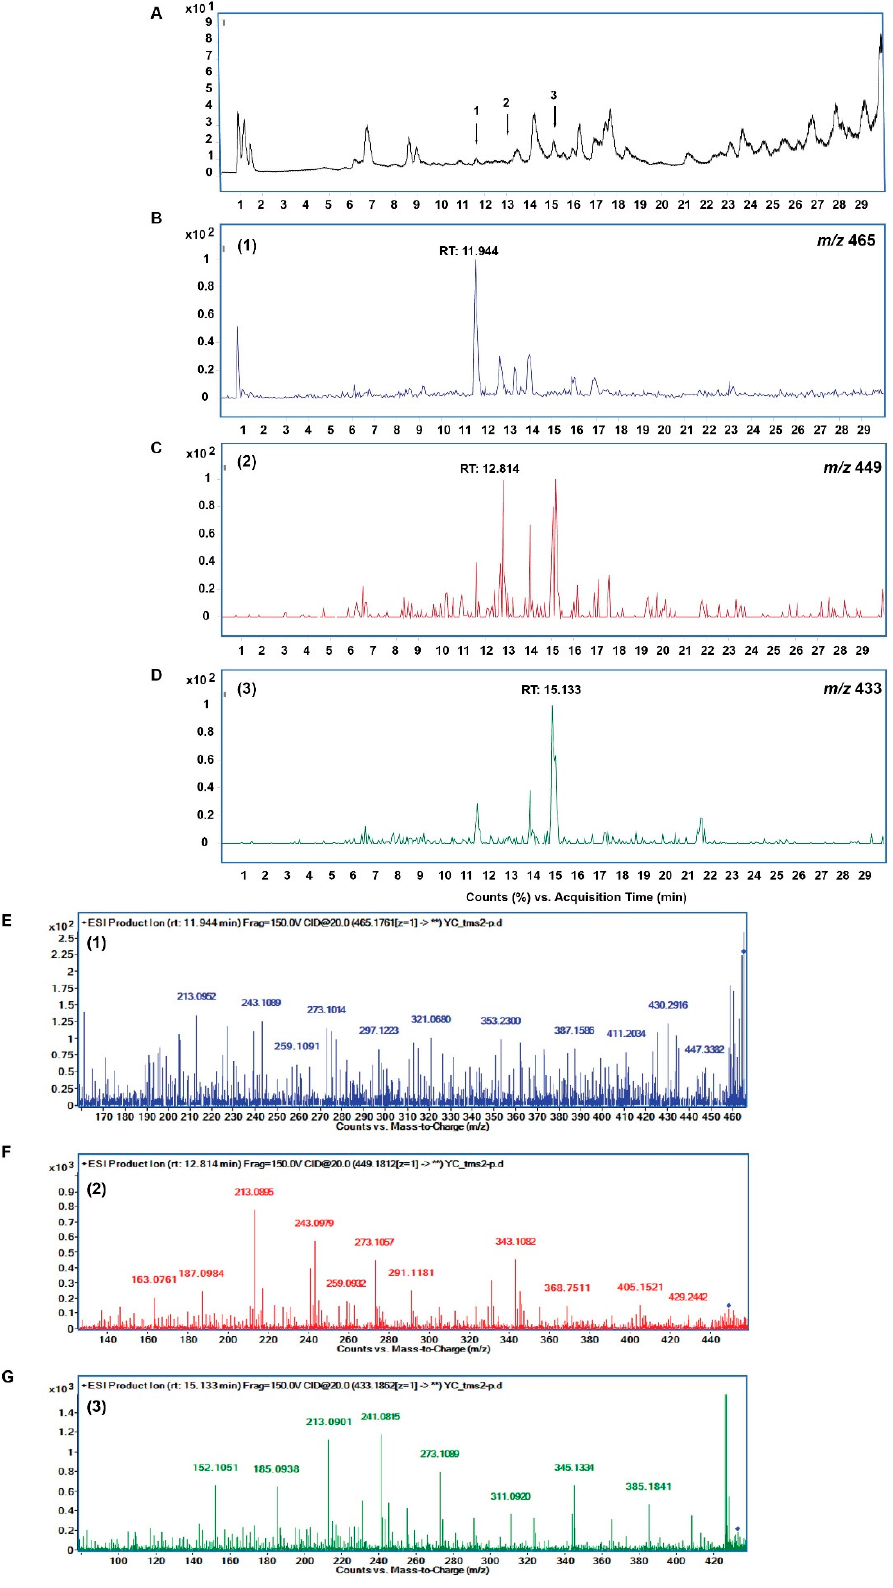
Figure 7. TIC in the positive mode of YLE ( A ). EIC of m/z 465.1761 (±10.0 ppm) [C 23 H 28 O 10 + H] + ( B ); EIC of m/z 449.1812 (±10.0 ppm) [C 23 H 28 O 9 + H] + ( C ); EIC of m/z 433.1862 (±10.0 ppm) [C 23 H 28 O 8 +H] + ( D ). Product-ion chromatograms of compound 1 ( E ), compound 2 ( F ), and compound 3 ( G ). 3. Discussion